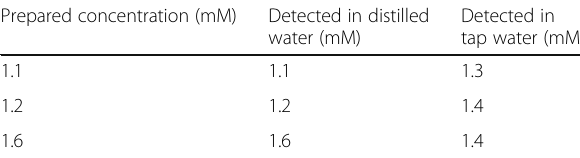
Table 1 Concentrations of Ni 2+ detected in distilled water and tap water ( n =